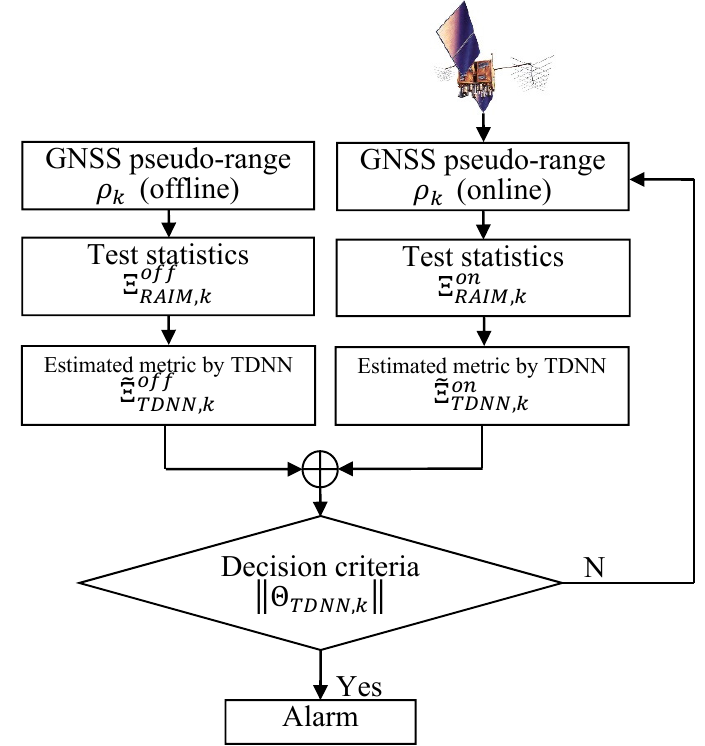
Figure 2. Schematic of the proposed integrity monitoring strategy based on estimated measurements made by TDNN.